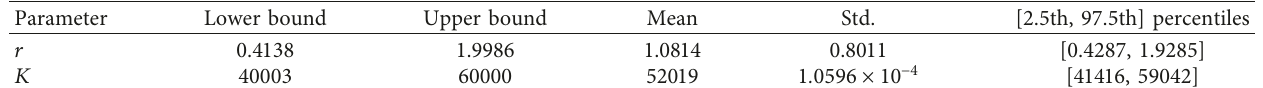
is 50000 and 54000, the peak of cumulative number of K reaches about 280 times. So, the results of estimated pa- rameters are not particularly good.